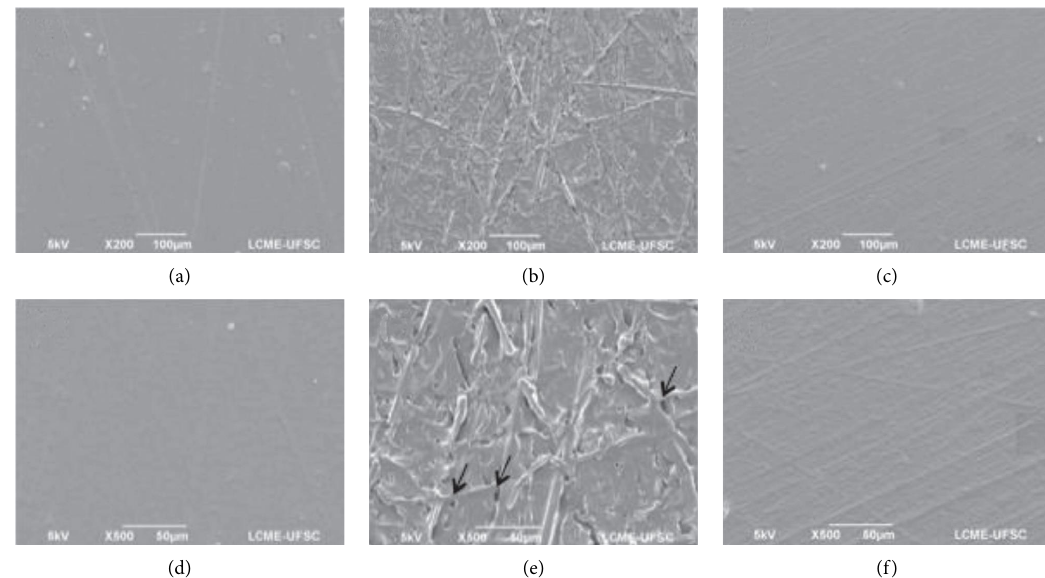
Figure 1: SEM images of smooth membranes at 200X: (a) as-received, (b) after acidic degradation, and (c) after basic degradation; and at 500X: (d) as-received, (e) after acidic degradation, and (f) after basic degradation.